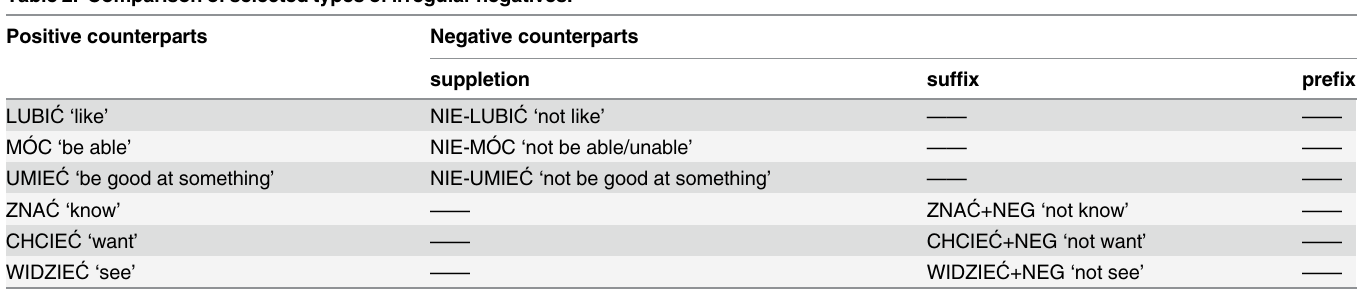
Table 2. Comparison of selected types of irregular